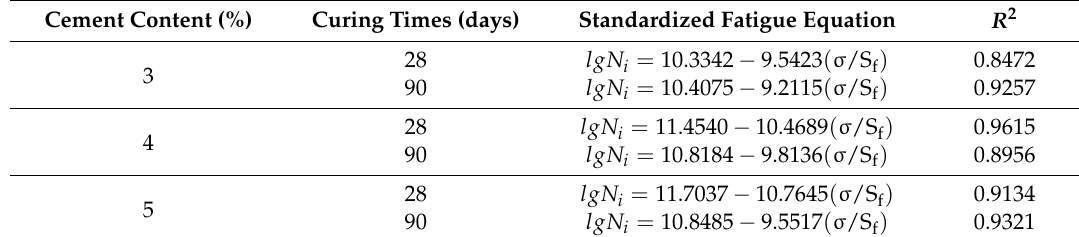
Table 9. Summary of the fitting results obtained for the standardization equation with different stress states at a guaranteed rate of